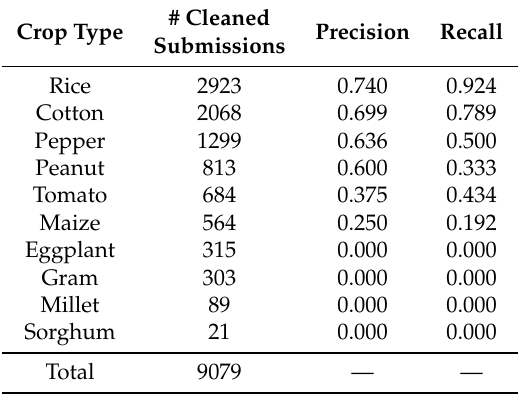
Table 4. Training set size, precision, and recall on the 10-crop task. Training set sizes are shown for the Plantix submissions that have < 50 m GPS accuracy and are ≥ 50% in a crop field. Precision and recall are displayed for the 1D CNN trained on combined Sentinel-2 and Sentinel-1